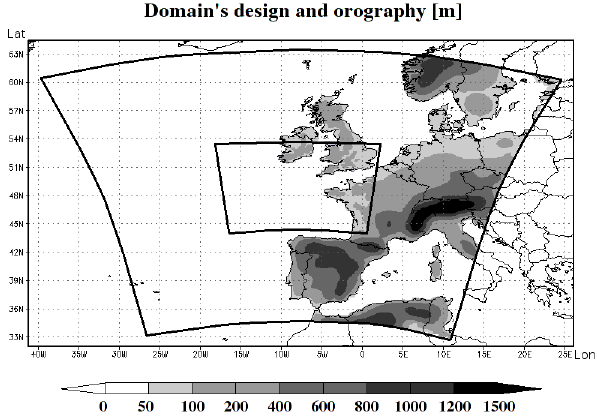
Fig. 1. RegCM/CAMx model domain’s position, and orography (in meters) with the outer 50km × 50km domain and the nested 10km × 10km domain. The shape of the domains is arising from the inverse projection from the Lambert conformal conic projection (LCC) plane to the lat-lon coordinate